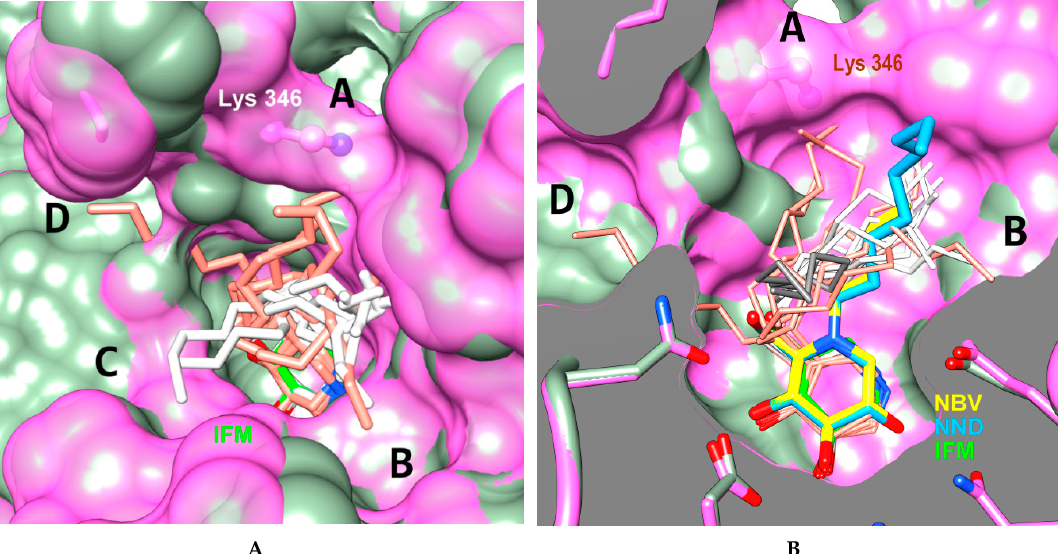
Figure 4. Combination of best docked poses (sticks, thin sticks) for compound 6b using protocols P1-OPT (salmon) and P2-GPU (white or gray) in 2NSX (chain B, light green) and 2WCG (chain A, pink surface) binding cavity ( A : surface view, B : clipped view). The PDB IFM ligand (IFG) (green) of structure 2NSX is shown in the bottom of active site and LYS346 residue of 2WCGa is highlighted. The PDB ligands NBV ( N -butyl DNJ) (yellow, structure 2V3D, chain A), NND ( N -nonyl DNJ) (blue, structure 2V3E, chain A) and aliphatic chains of 6b that fluctuate in C channel (gray, other poses in white) are shown in Figure 4B. Letters A to D reffer to the channels explored by the lipophilic chains.